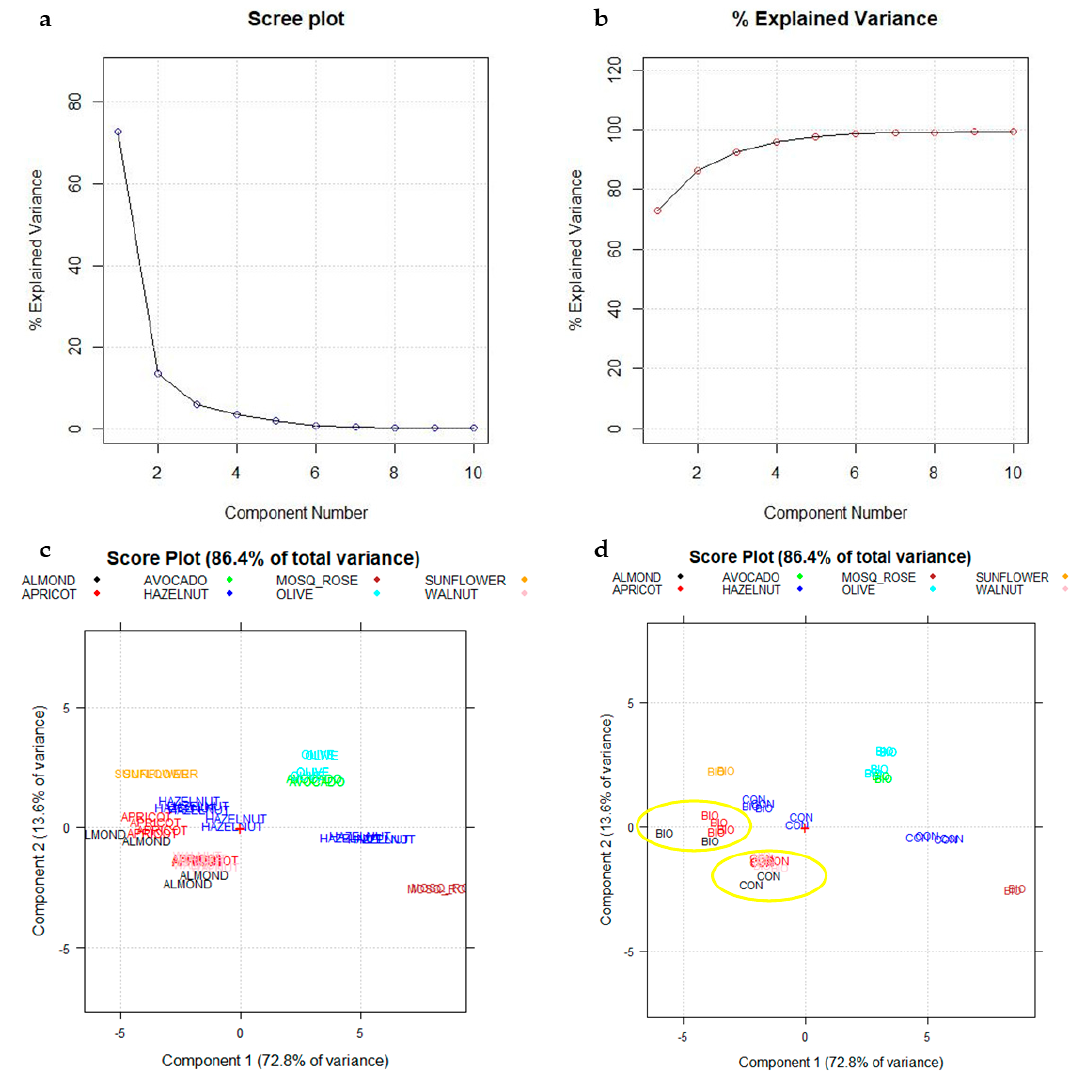
Figure 7. ( a , b ) Scree plot and percentage of explained variance plot; ( c ) Score plot PC1–PC2. Each vegetable species is reported with a different color; ( d ) Conventional (CON) and biological (BIO) samples have been highlighted. + sign in the plots correspond to the origin (point 0,0).